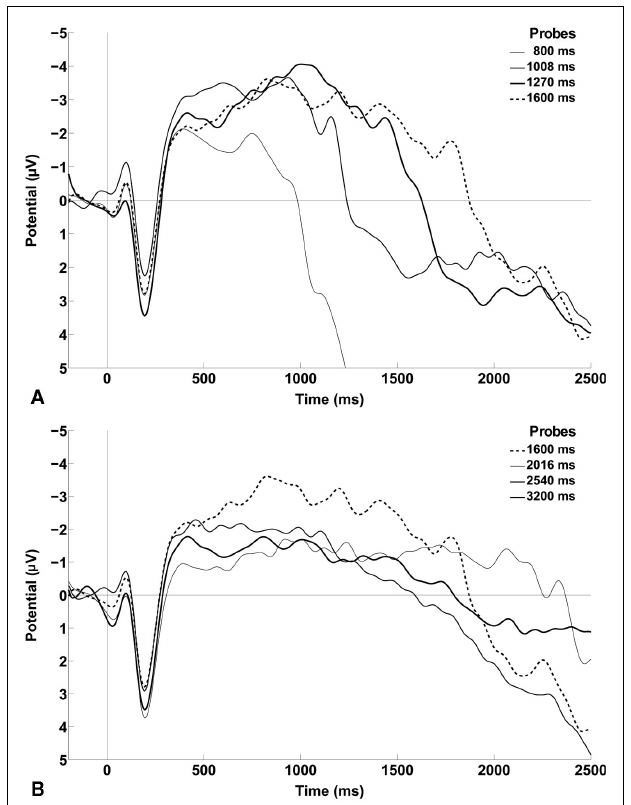
FIGURE 2 | Grand average of the ERP waveforms obtained by collapsing across the six frontal and central electrodes of interest (i.e., FCz, FC1, FC2, C1, C2, and Cz) time-locked to stimulus onset. (A) ERPs of the first four probe durations in the series: 800, 1008, 1270, and 1600ms. (B) ERPs of the last four probe durations in the series: 1600, 2016, 2540, and 3200ms.The ERP of 1600ms is plotted in both panels for comparison.The data were smoothed with an eight-point Gaussian window for presentation only.